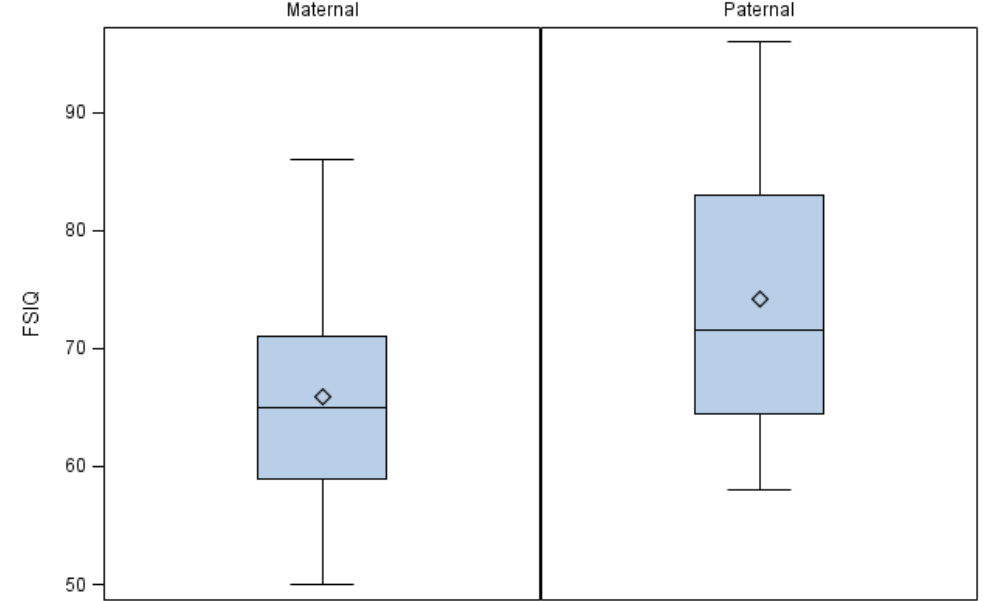
Figure 2. Individuals with inherited deletions of maternal origin were found to have a lower median FSIQ than those of paternal origin.